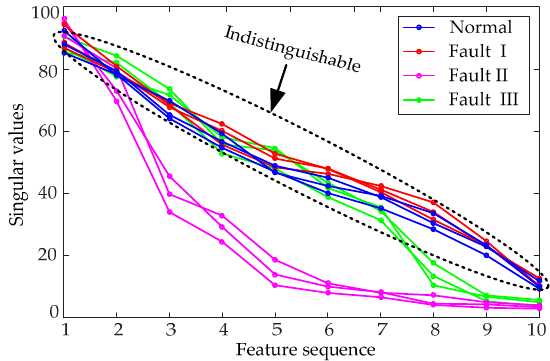
Figure 12. The WSV feature vectors of different types of vibration signals.